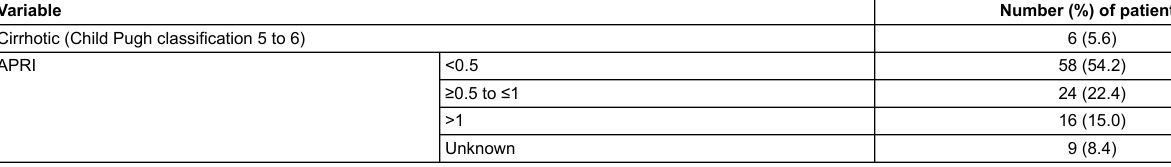
Table S2: Additional disease characteristics (safety population, N = 107).